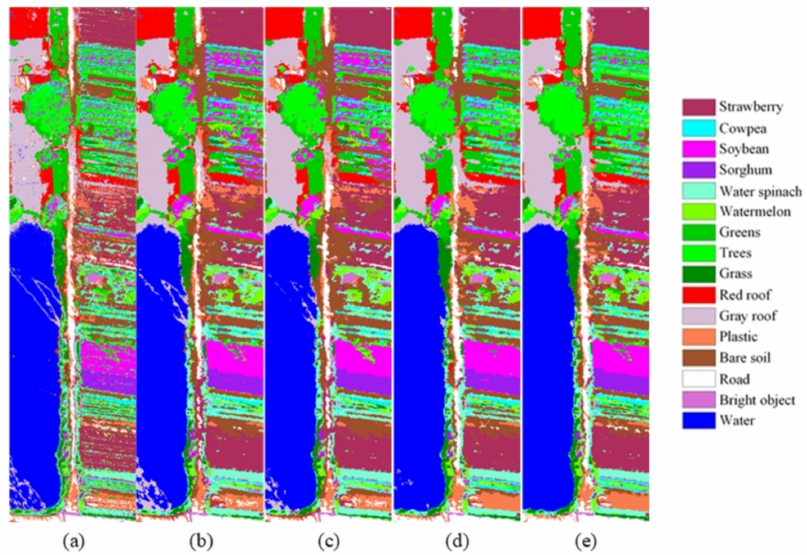
Figure 15. The classification results for the Hanchuan dataset using RF: ( a ) Pixel-wise spectral classification; ( b ) MLF; ( c ) MPF; ( d ) MLV; ( e )